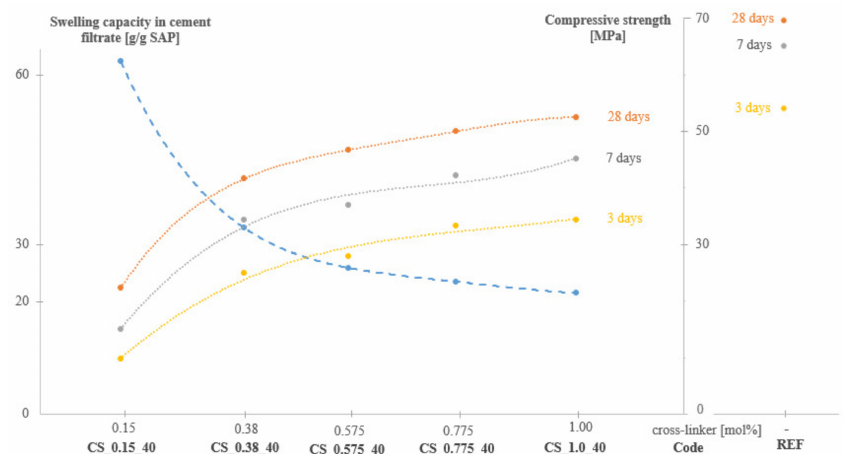
Figure 4. Swelling capacity in cement filtrate and mortar compressive strength (n = 6) after 3, 7 and 28 days for SAPs with di ff erent amounts of cross-linker, compared to the reference.